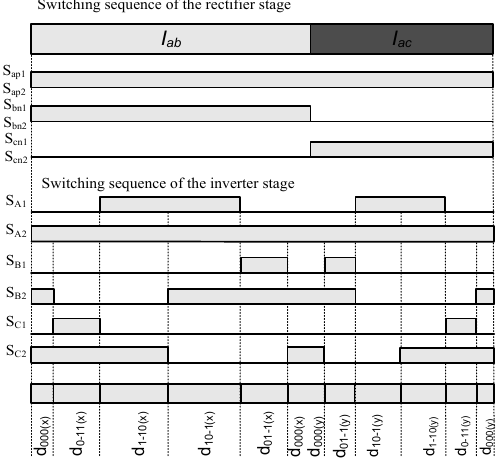
Figure 7. The switching pattern of the multilevel IMC with the proposed SVPWM method.